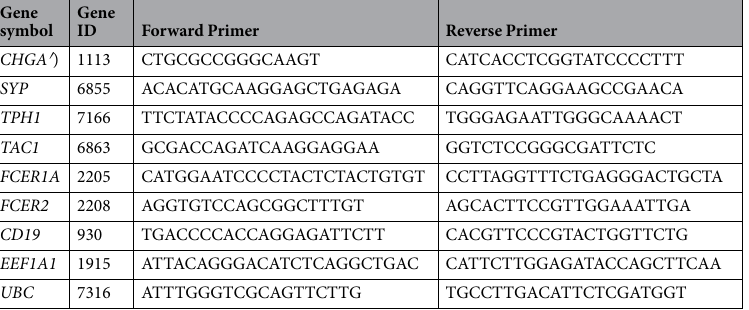
Table 1. Real-time PCR primers. Gene symbol, Gene ID and sequences of forward and reverse primers are indicated. ′ ) Gene names: chromogranin A ( CHGA ), synaptophysin ( SYP ), tryptophan hydroxylase 1 ( TPH1